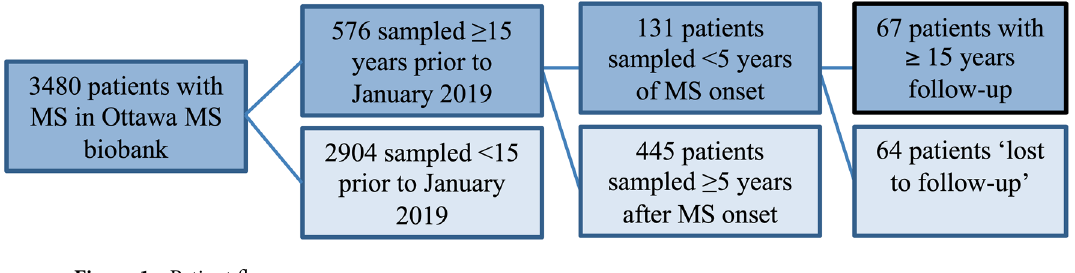
Figure 1. Patient